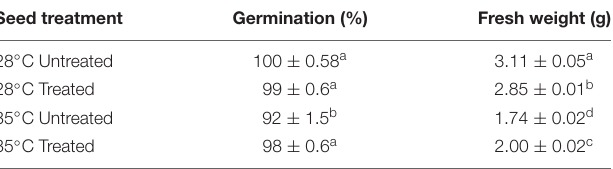
TABLE 1 | Germination percentage and fresh weight at 48 h after seed incubation. Seed treatment Germination